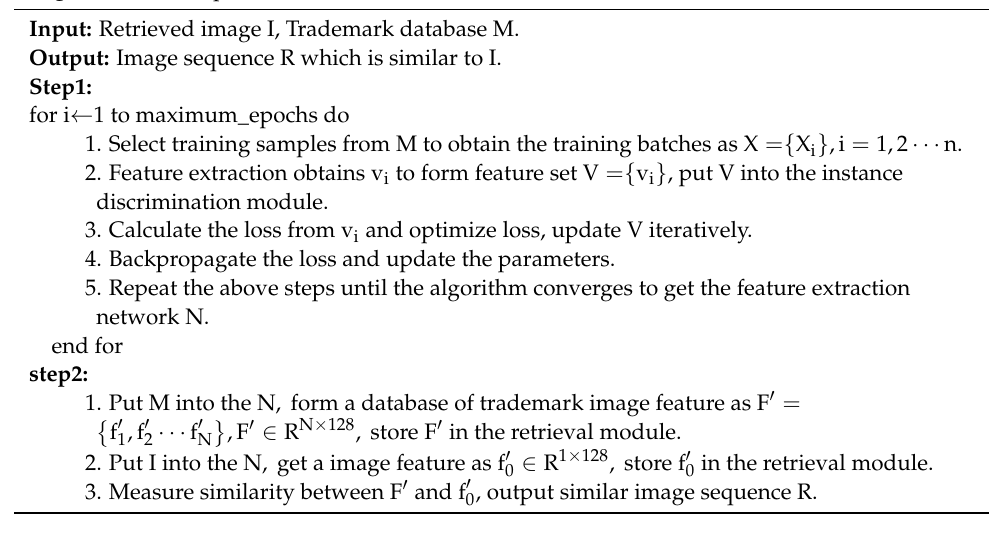
Algorithm1: Unsupervised trademark retrieval method based on attention mechanism